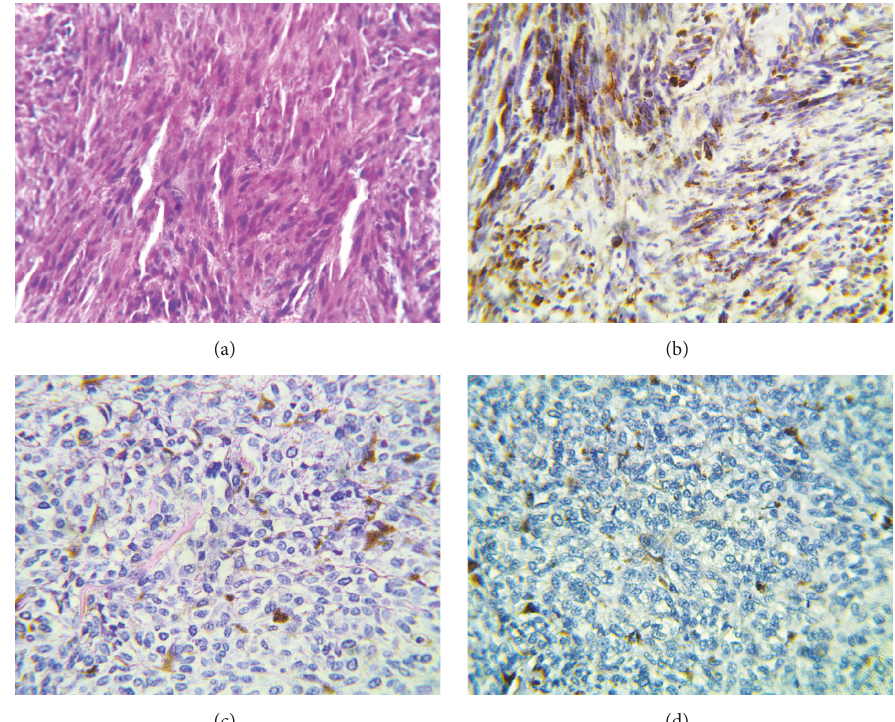
Figure 1: (a) Photomicrograph of case 44 stained with H&E (Magnification x 400); (b) positive staining with VE1 antibody for BRAF V600E in case 46 (Magnification x 400). Note the brown cytoplasmic staining of the tumour cells; (c) photomicrograph of case 25 stained with H&E (Magnification x 400). There are scattered melanin laden macrophages in the background; (d) negative staining with VE1 antibody for BRAF V600E in case 25 (Magnification x 400). There is no brown cytoplasmic staining of the tumour cells.